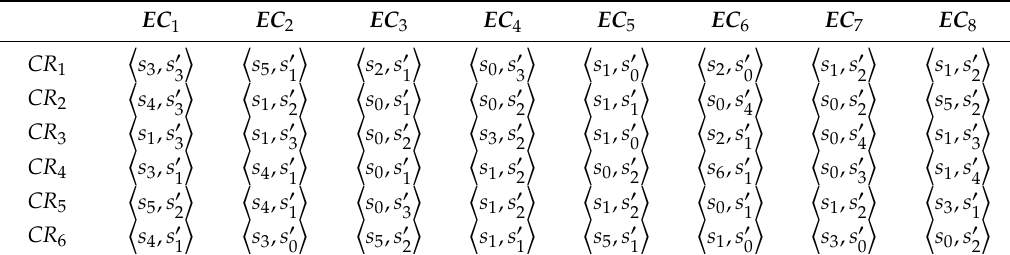
Table 6. The negative ideal assessment—minimum value.